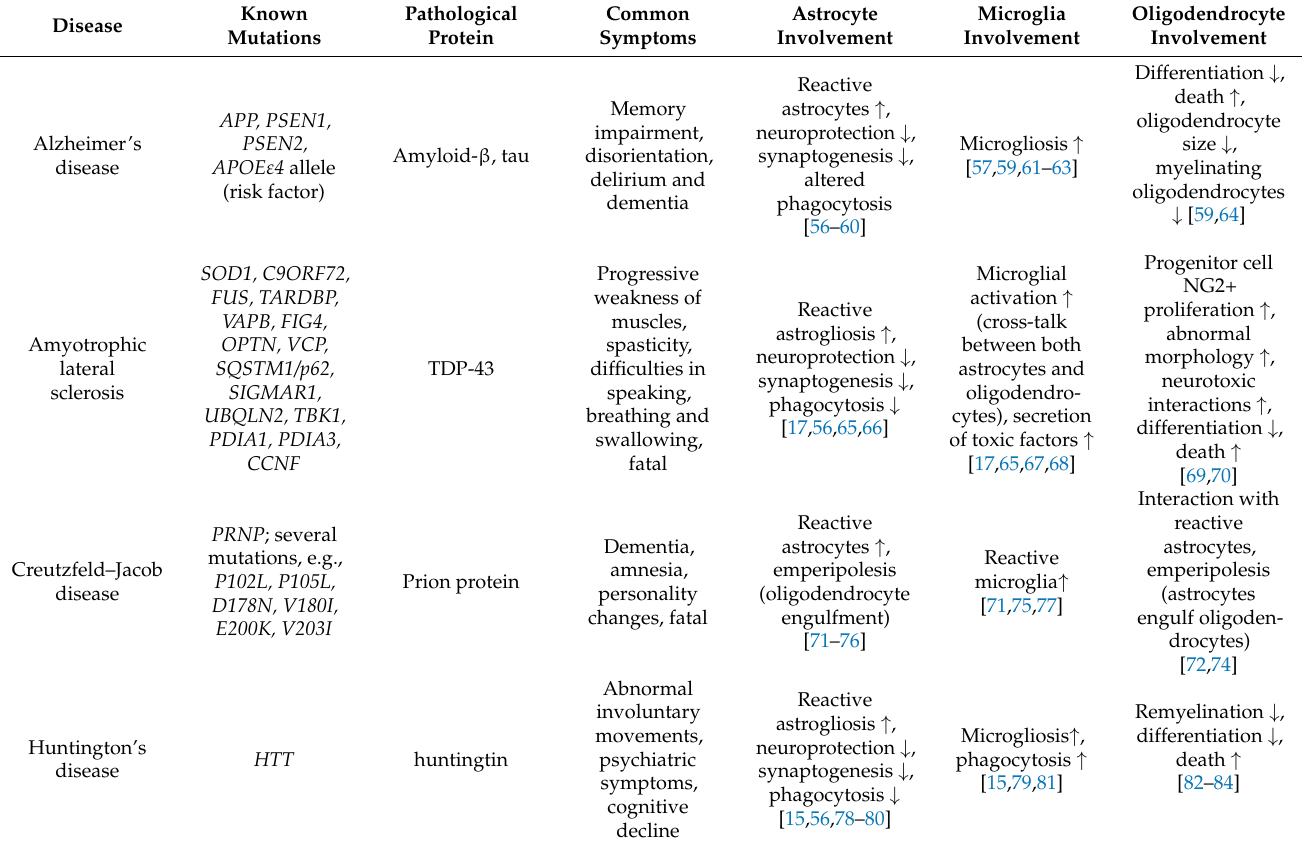
Table 1. Table of the most common neurodegenerative diseases with their major properties and how glial cells are involved in each